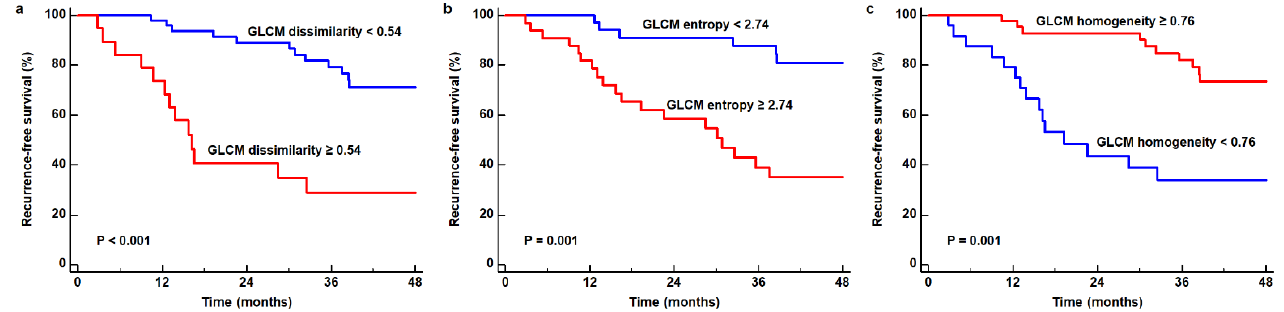
Figure 1. Cumulative recurrence-free survival curves based on the GLCM dissimilarity ( a ), GLCM entropy ( b ), and GLCM homogeneity ( c ) of perigastric entropy ( b ), and GLCM homogeneity ( c ) of perigastric AT.